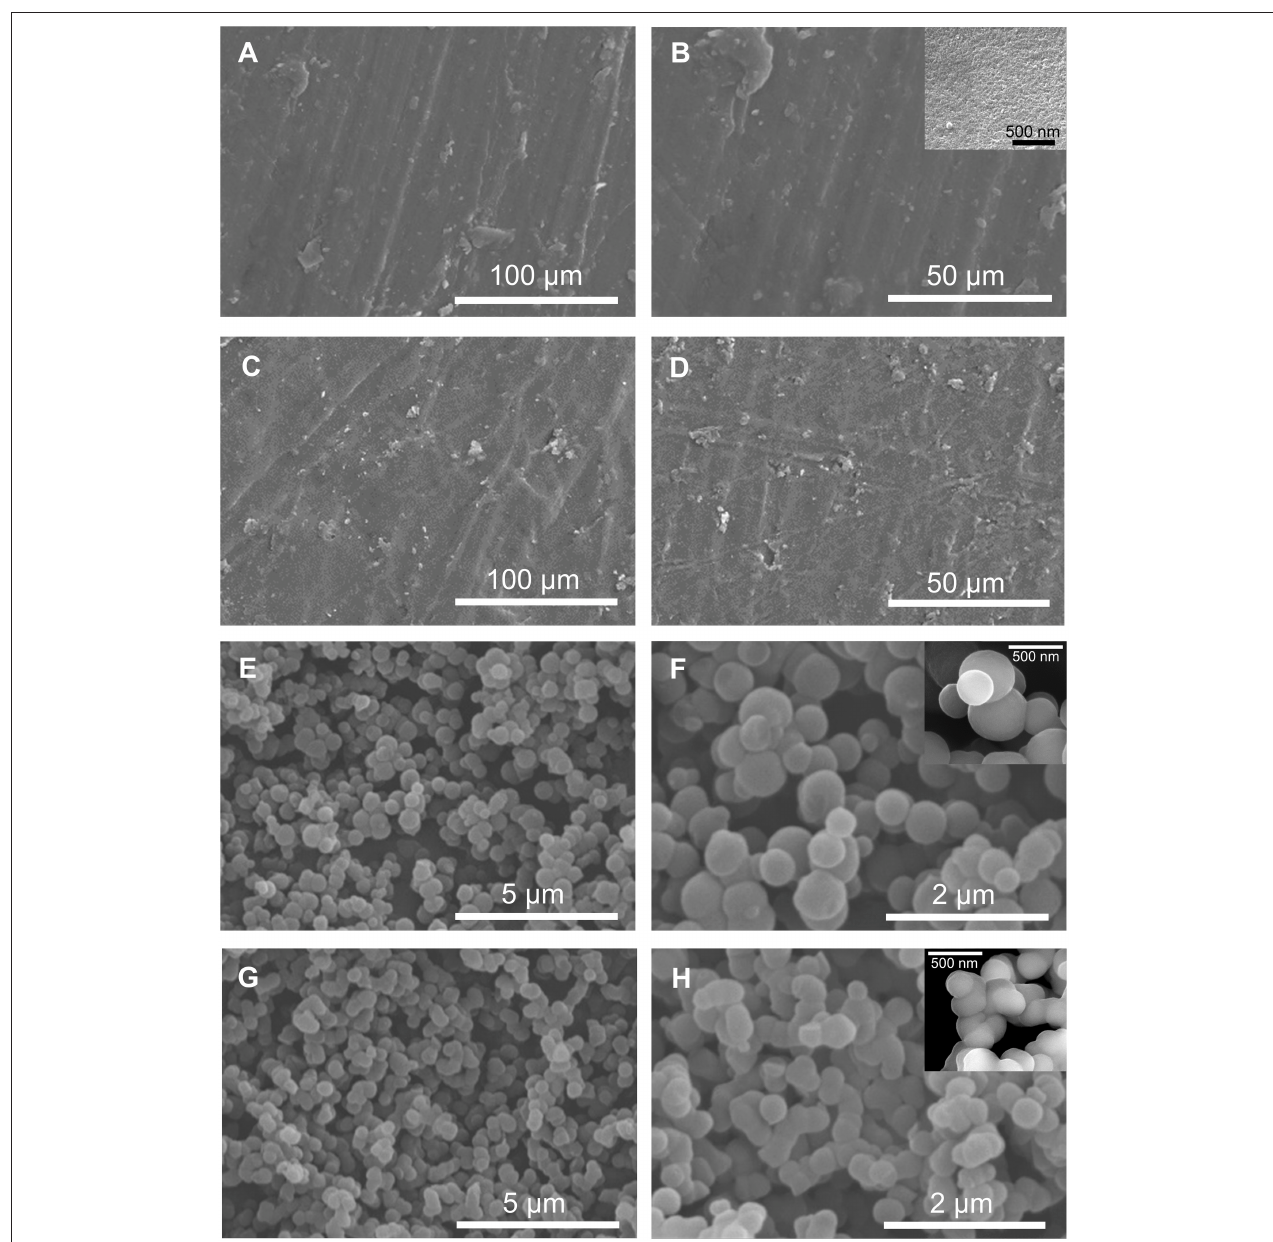
FIGURE 4 | SEM images of the BS-1 (A,B) , BS-2 (C,D) , BS-3 (E,F) , and BS-4 (G,H)